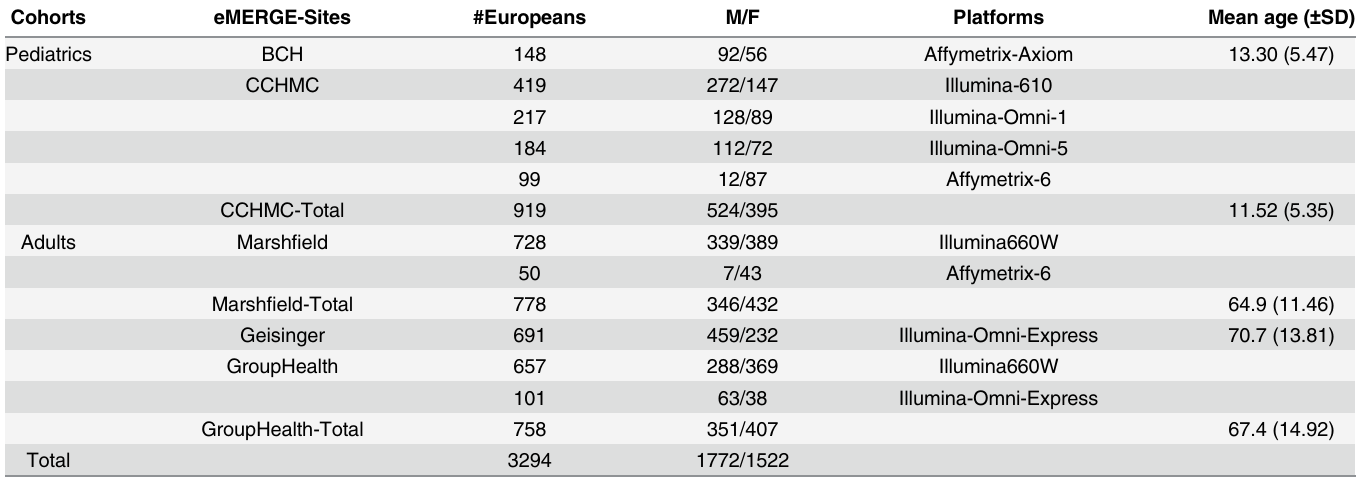
Table 1. The demographic distribution of EMR-linked eMERGE cohorts. Cohorts